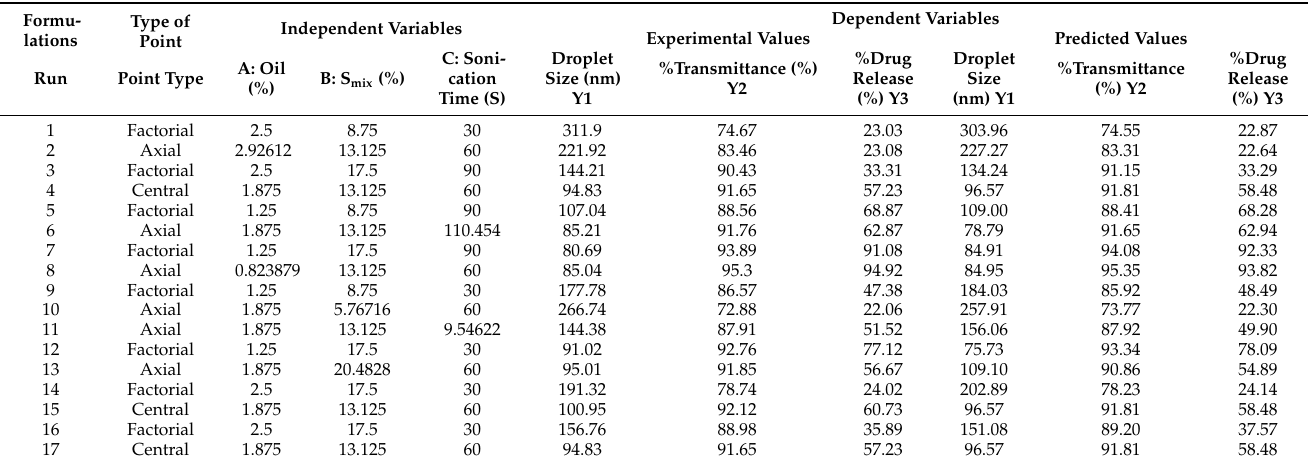
Table 2. CCD-observed AZL-NE formulation experimental runs along with experimental values and predicted values for dependent variables.